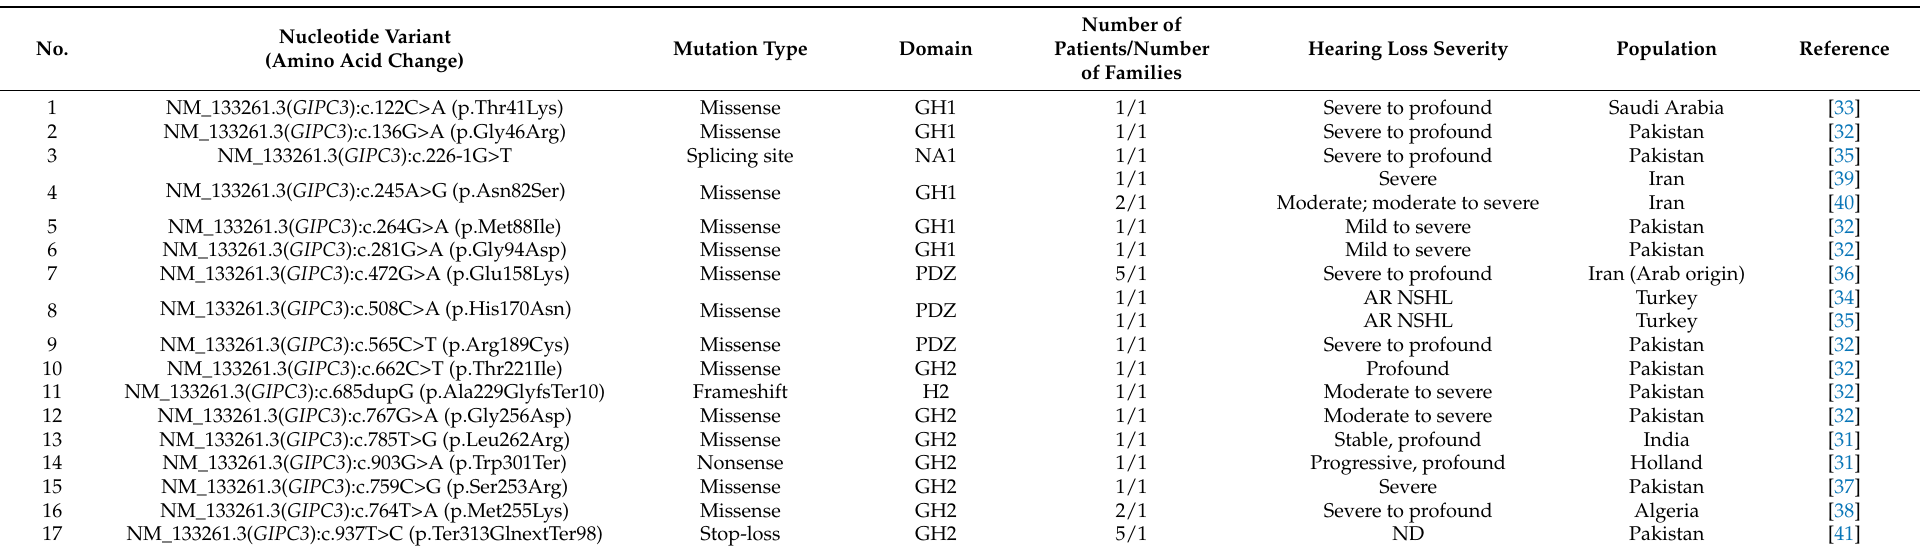
Table 4. Mutations in the GIPC3 gene associated with hearing loss described in the